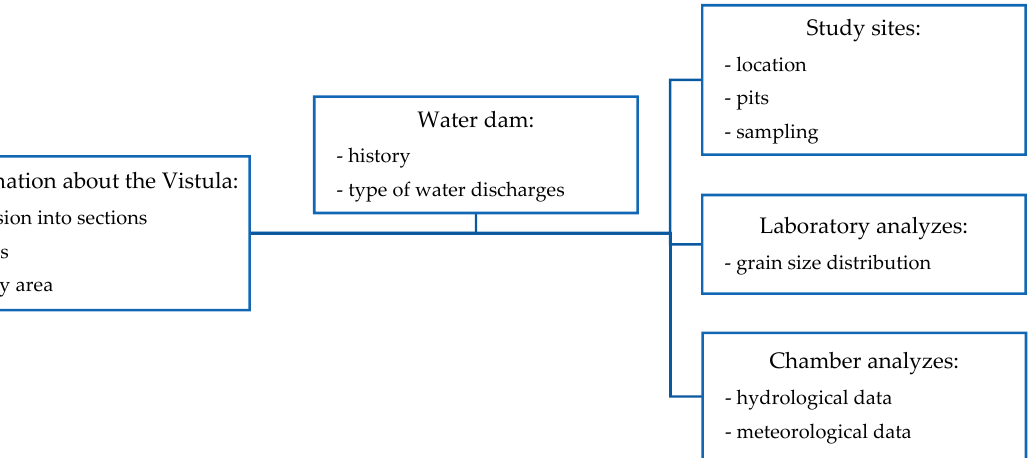
Figure 1. The flowchart describes the methodological approach applied in this study. The Vistula, between 1970 and 2005, had mean annual flow rates of 895 m 3 s − 1 and 1004 m 3 s − 1 in Włocławek and Toru´n, respectively. In wet years (1971,